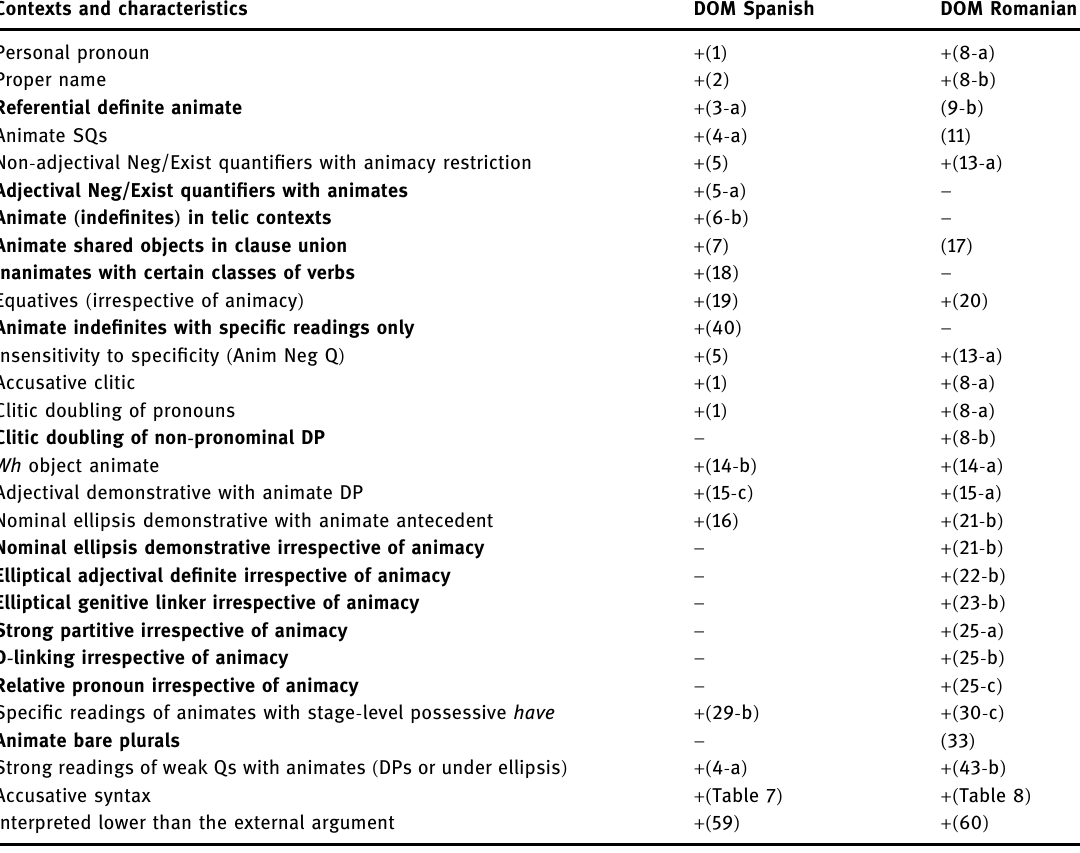
Contexts and characteristics